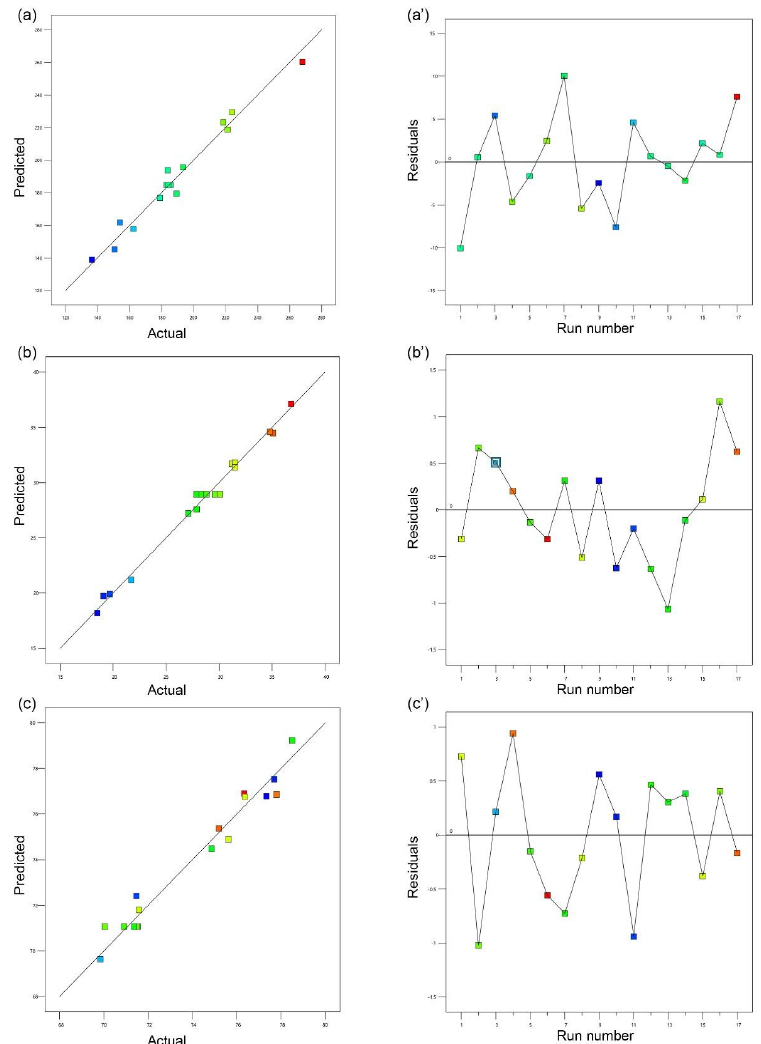
Figure 3. Liner correlation plot ( a – c ) between predicted and actual values and corresponding residual plot ( a’ – c’ ) for the three responses, i.e., mean particle size (nm), ZP (mV), and EE(%) for the CUR/LCSNPs. The scattered residual plot indicates the spread of the dependent variables under 17 different experimental conditions (run